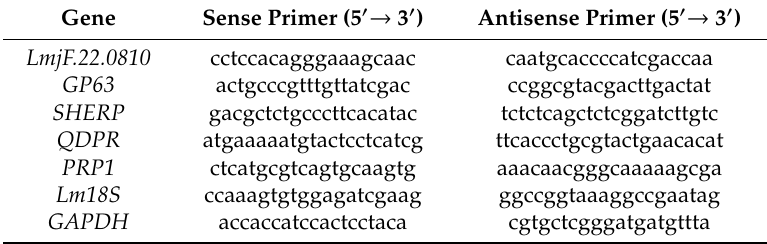
Table 1. Primer sequences used for the quantification of Leishmania